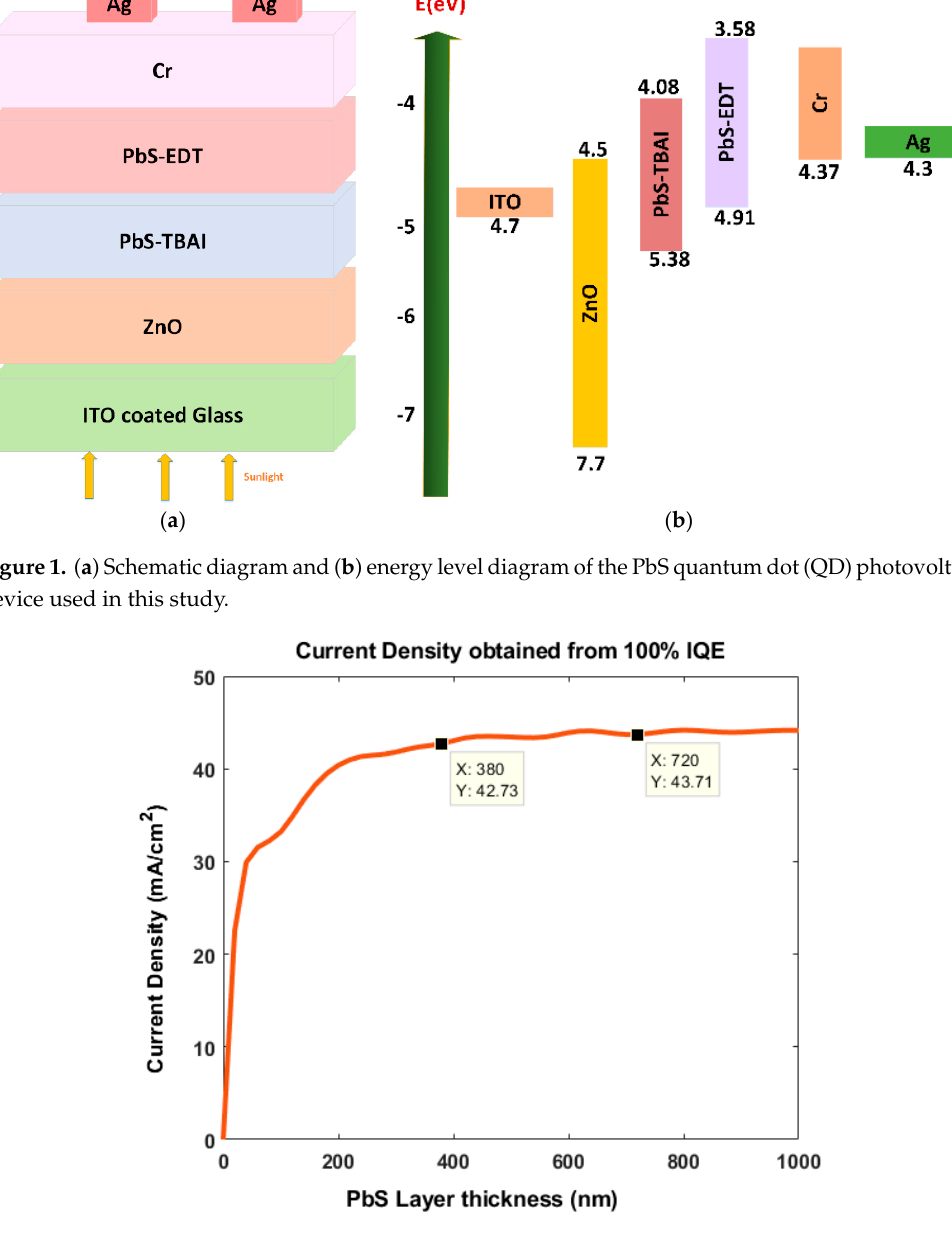
Figure 2. Variation of the active layer thickness to achieve the maximum current density.